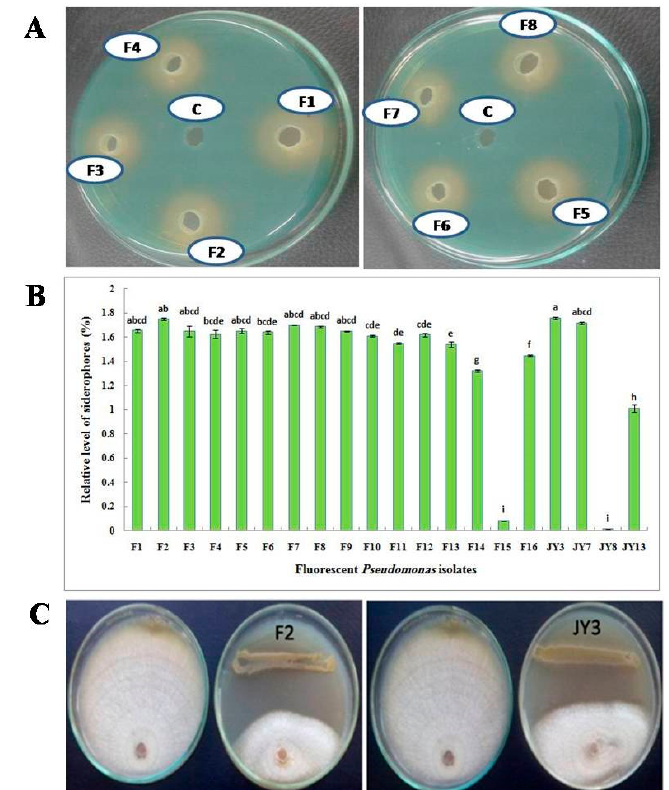
Figure 1. ( A ) Qualitative assay of siderophore production on chrome azurol S (CAS) agar plates using supernatant of some fluorescent Pseudomonas isolates; ( B ) Relative level of siderophores produced by fluorescent Pseudomonas isolates grown on succinic medium using CAS assay and ( C ) antagonistic e ff ect of Pseudomonas aeruginosa F2 and Pseudomonas fluorescens JY3 against Fusarium solani, plate on the left in each photo is the corresponding control without the antagonist (data are presented in Table